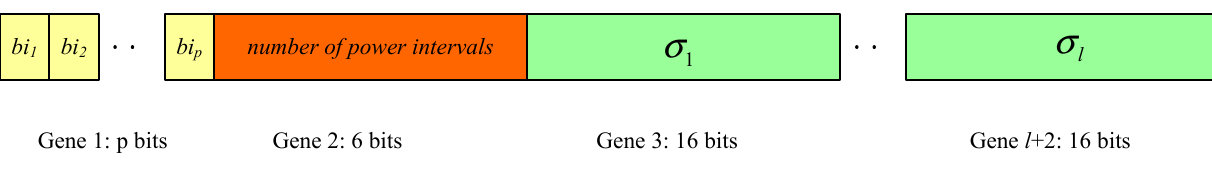
Figure 2. Structure of the chromosome used in the optimization of the HISIMI